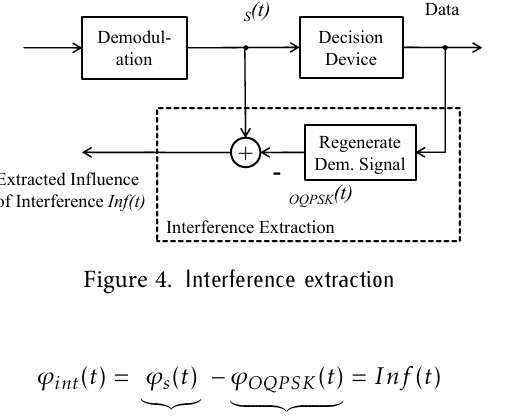
Figure 2. Demodulation of OQPSK signal